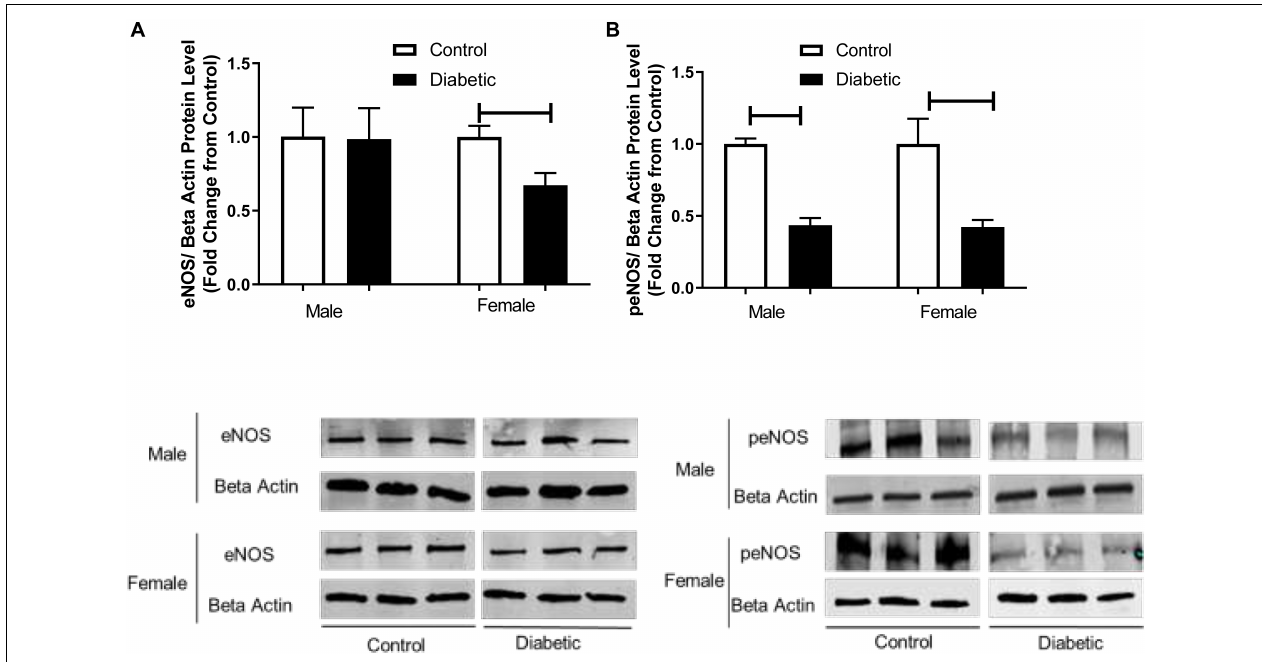
FIGURE 7 | Western blot analysis of eNOS and peNOS expression in control and UCD-T2DM rat aorta. Protein levels of (A) total endothelial nitric oxide synthase (eNOS) and (B) phosphorylated eNOS (peNOS) in aortic samples from male and female control and diabetic rats. eNOS (A) and peNOS (B) were quantified by densitometry and normalized to corresponding beta actin. Each bar represents the mean ± SEM of values obtained from n = 4–5 animals per group. To show representative bands, images from different parts of the same gel have been juxtaposed, indicated by white dividing lines. Capped lines indicate significant differences between two groups ( p < 0.05), as analyzed by unpaired Student’s t